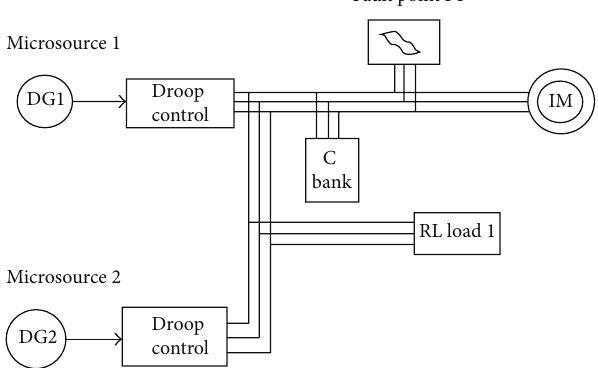
Figure 4: Single line layout of the utility and microgrid